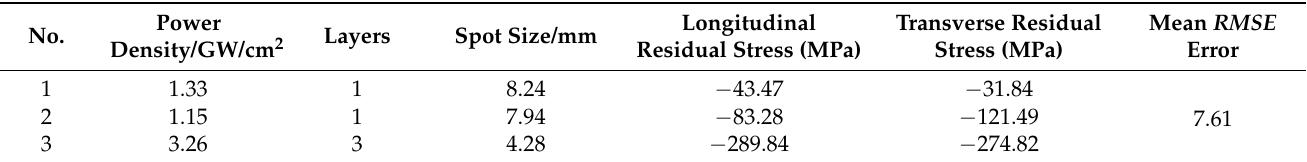
Table 8. Optimised input parameters using the GA to obtain the desired parameters in Table 7 with three degrees of freedom (only relative depth fixed as an input parameter).